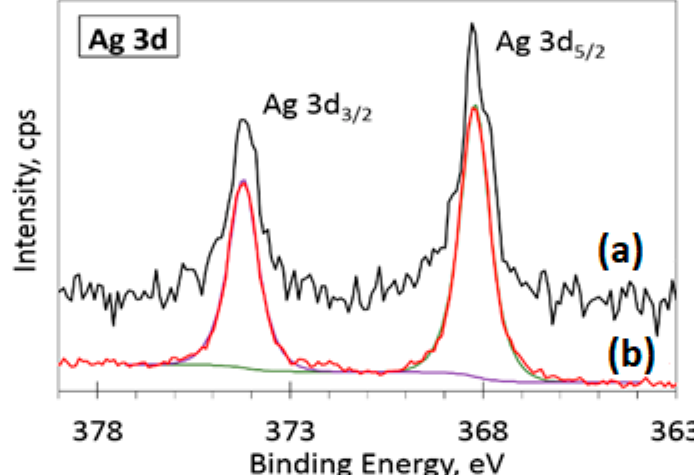
Figure 6. Deconvoluted high-resolution XPS spectra in O 1s region for ( a ) ZnO and ( b ) 10% Ag-ZnO powder samples.